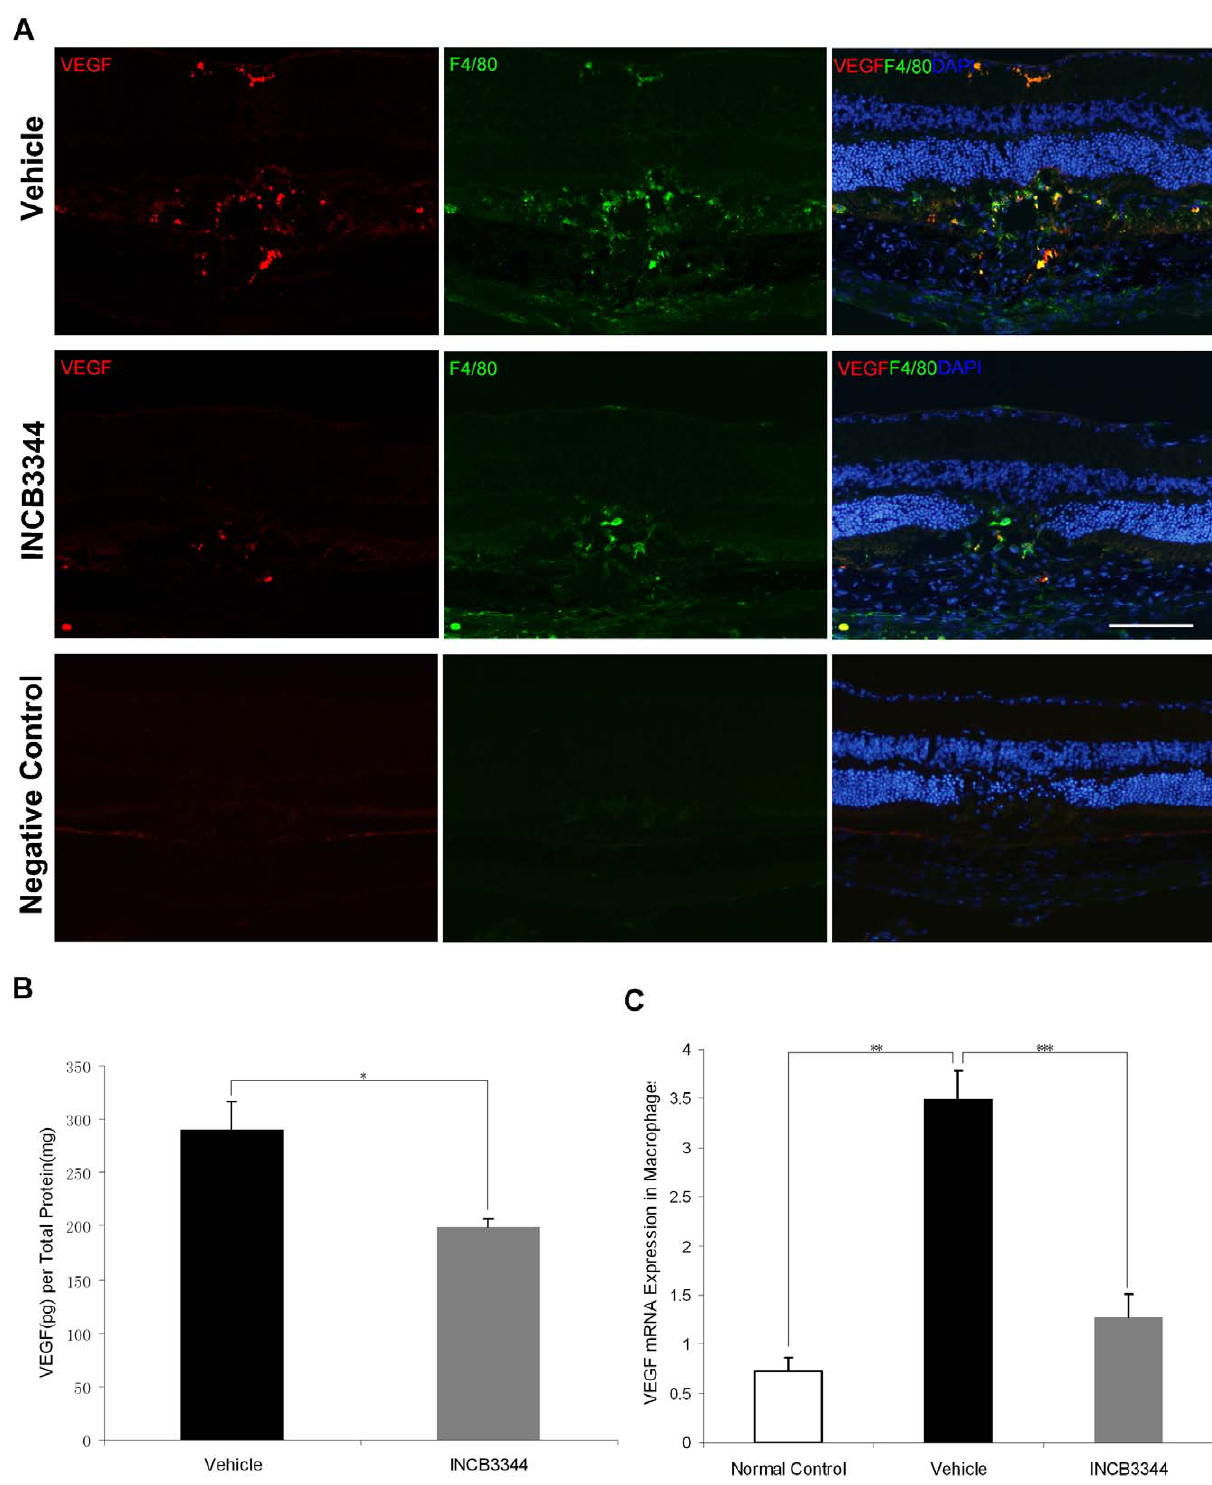
Figure 3. VEGF expression. ( A ) Immunohistochemistry of macrophages (green) and VEGF (red) in cryosections on Day 3. Significantly higher levels of VEGF were expressed in macrophages at the photocoagulated sites. VEGF localized mainly in infiltrating macrophages at the laser injury sites. INCB3344 apparently decreased VEGF immunoreactivity compared to vehicle treatment. The negative control omitting the primary antibody (second antibody only) had detectable auto-fluorescence in RPE. Scale bar=100 m m. ( B ) VEGF protein levels in the choroid-RPE were quantitatively measured by ELISA. VEGF levels on Day 3 were significantly suppressed by INCB3344 treatment. ( n =8, * P =0.012). ( C ) The expression of VEGF mRNA derived from macrophages isolated from choroid-RPE complexes was detected by real-time PCR on Day 3 after photocoagulation. The increased VEGF mRNA expression in infiltrating macrophages was significantly suppressed by INCB3344 treatment (**,*** P , 0.001, n =3).